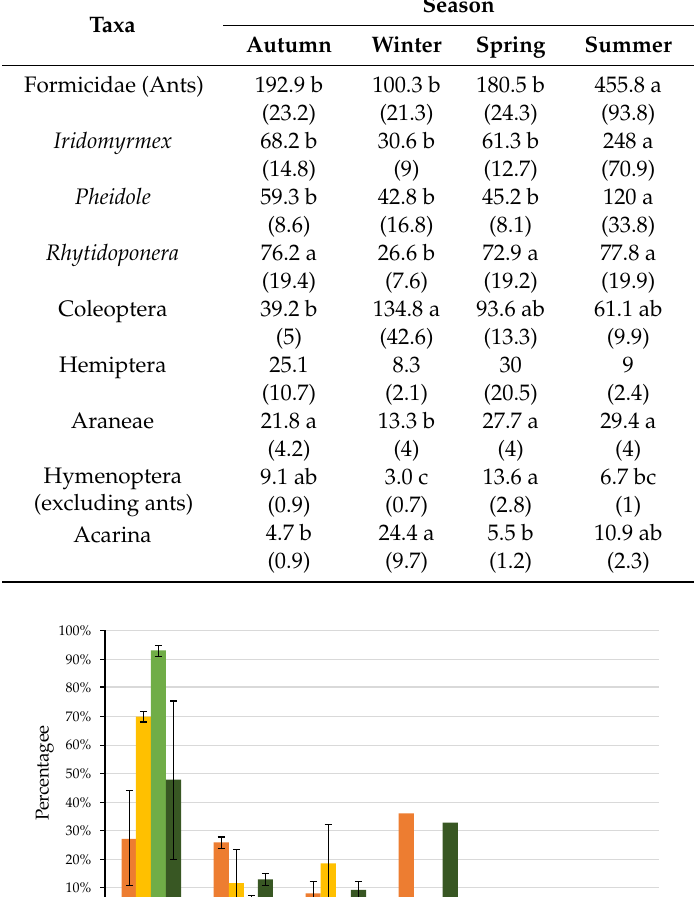
Table 3. Mean abundance (standard error of mean) of invertebrate taxa recorded in pitfall traps (total number per field), across season and presented from most to least abundant. Each data point was the total abundance of 20 pitfall traps per field. Each field was sampled once in each of the four seasons and repeated in the following calendar year, n = 48. Within rows and category, means followed by different letters were significantly different at p < 0.05. Comparison of mean (Tukey’s HSD) were completed within the category of season. In addition, within rows, means followed by different letters were significantly different at p < 0.05.